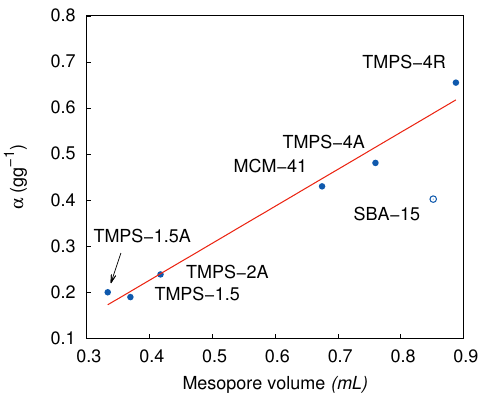
Figure 9. Dependence of α on the measured mesoporous volume. Solid line represents the linear regression.